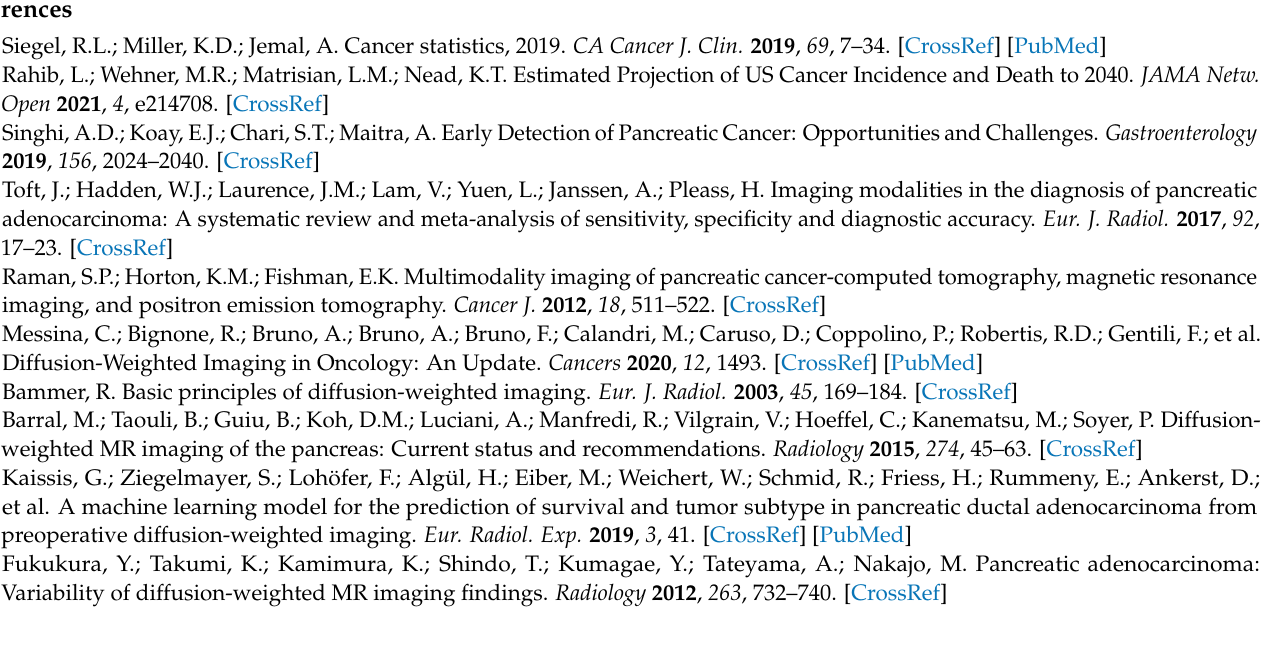
Figure A1. Patient inclusion flowchart.